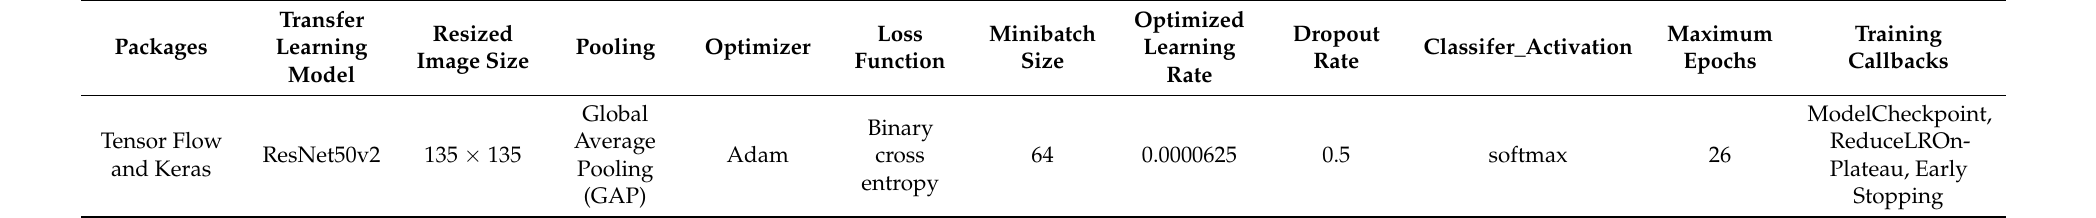
Table 5. Hyperparameters settings of the best-performing model (ResNet50v2) on the training and validation